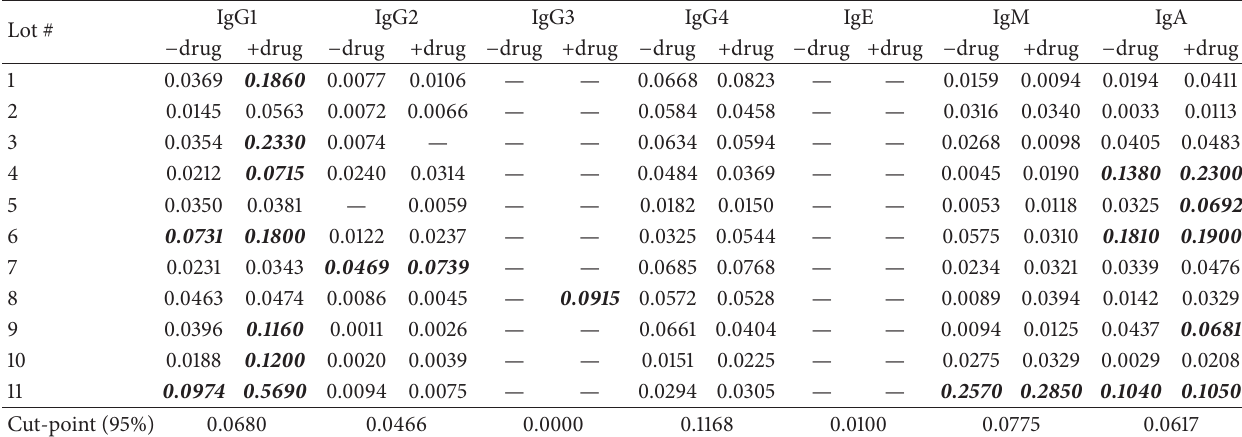
Table 6: LC/MS peak area ratio responses and calculated ADA isotope/subclass levels in PEA positive human plasma with mouse Ab as ADA capture reagent (numbers in bold italic are above respective cut-points). Plasma samples were spiked with addition of excessive drug (+drug) or without ( − drug) addition of excessive